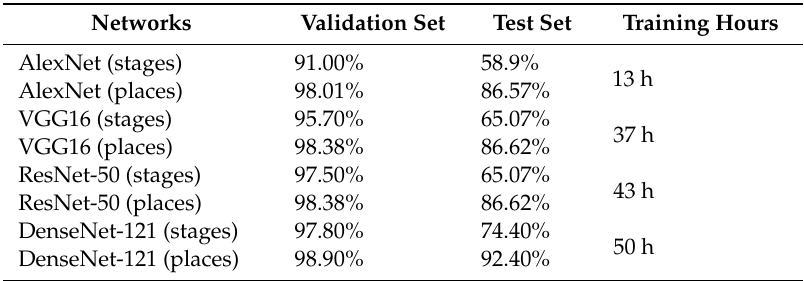
Table 6. The accuracy of fine classification by using four networks.